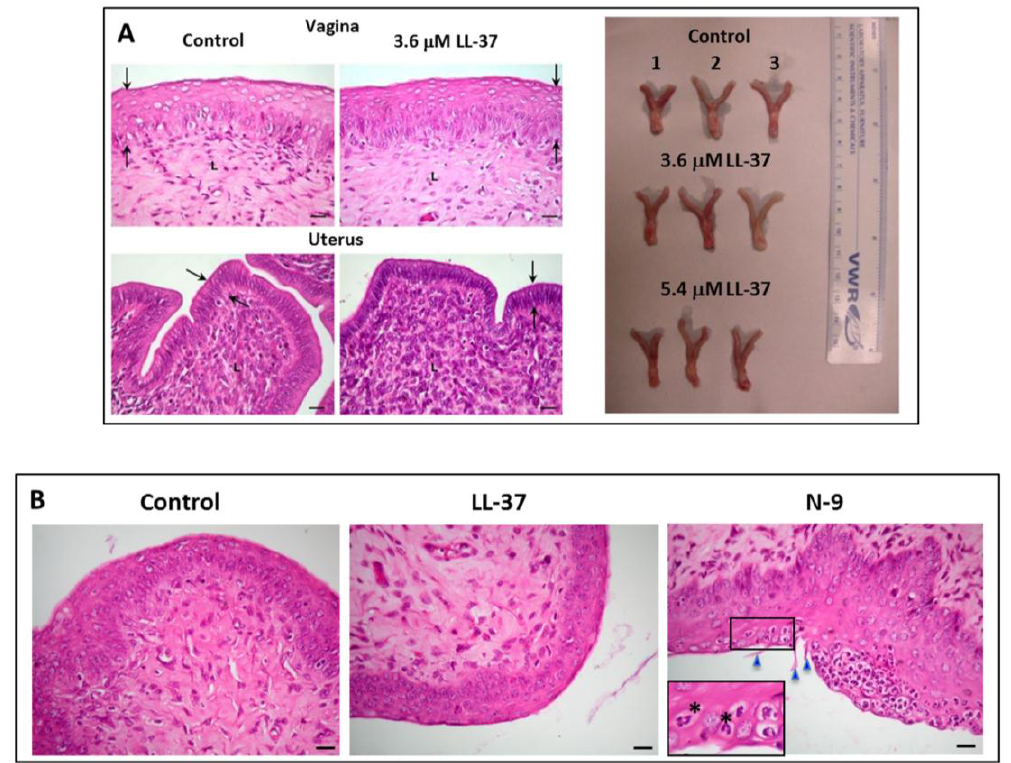
Figure 5. ( A ) Left panel: Normal histology of the vagina and uterus of female mice transcervically injected with LL-37 + sperm. The female reproductive tract tissues were collected for fixing and paraffin embedding one day after the transcervical injection of LL-37 + sperm, or sperm alone (control). Sections of the vagina and uterus revealed that the vaginal stratified epithelial cell layers and the uterine single epithelial cell layer (denoted as the area between the two arrows) as well as the corresponding lamina propria of the LL-37 treated and control animals did not differ from each other. Bar = 20 μm. This image was taken from our published article [79]. Right panel: The anatomy (shape, dimension and color) of the vagina/cervix and uterus, dissected from females injected with LL-37 (3.7or 5.4 μM) + sperm (n = 3 each) or sperm alone (control) (n = 3) one day after the injection, was the same among the three groups of the animals. ( B ) Absence of immune cell recruitment to the vaginal epithelium of mice transcervically injected with LL-37 + sperm. Sections of the vagina were prepared as in ( A ). The vaginal epithelium and lamina propria of both the control and LL-37 treated mice similarly show minimal numbers of immune cells, indicating no recruitment of these cells to the vagina as a consequence of LL-37 injection. In contrast, when females were transcervically injected with 2% nonoxynol-9 (N-9), numerous neutrophils were recruited into the vaginal epithelium. The polymorphonuclear structure of neutrophils is apparent in the close-up image (denoted by asterisks). Triangles point to the N-9 induced rupture of the vaginal epithelial surface. Bar = 20 μm.